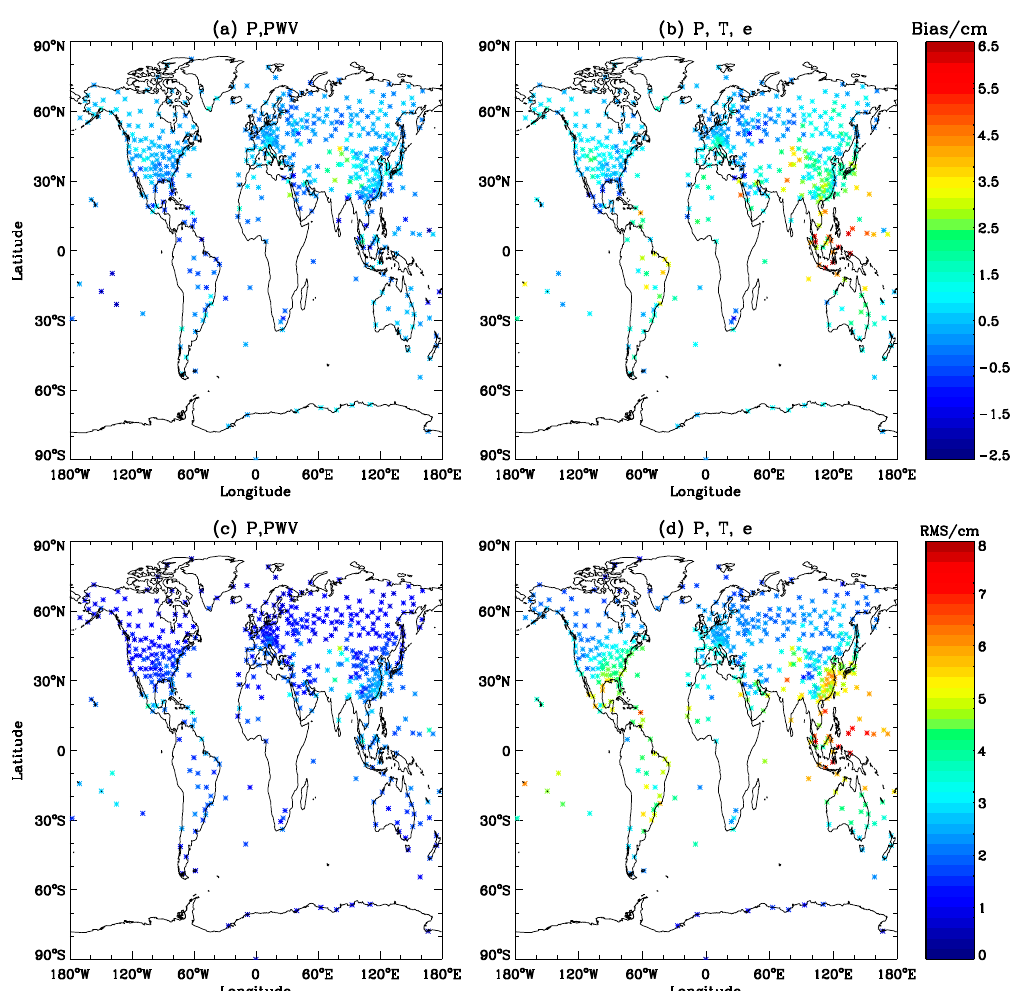
Figure 4. Global distributions of bias and RMS values of ZTDs derived from the ERA surface analysis data (2.5° × 2.5°) over 530 IGRA stations. ( a , c ) refer to results obtained using P , T , e , and PWV parameters; ( b , d ) refer to results obtained using P , T , and e parameters with the A&N model.